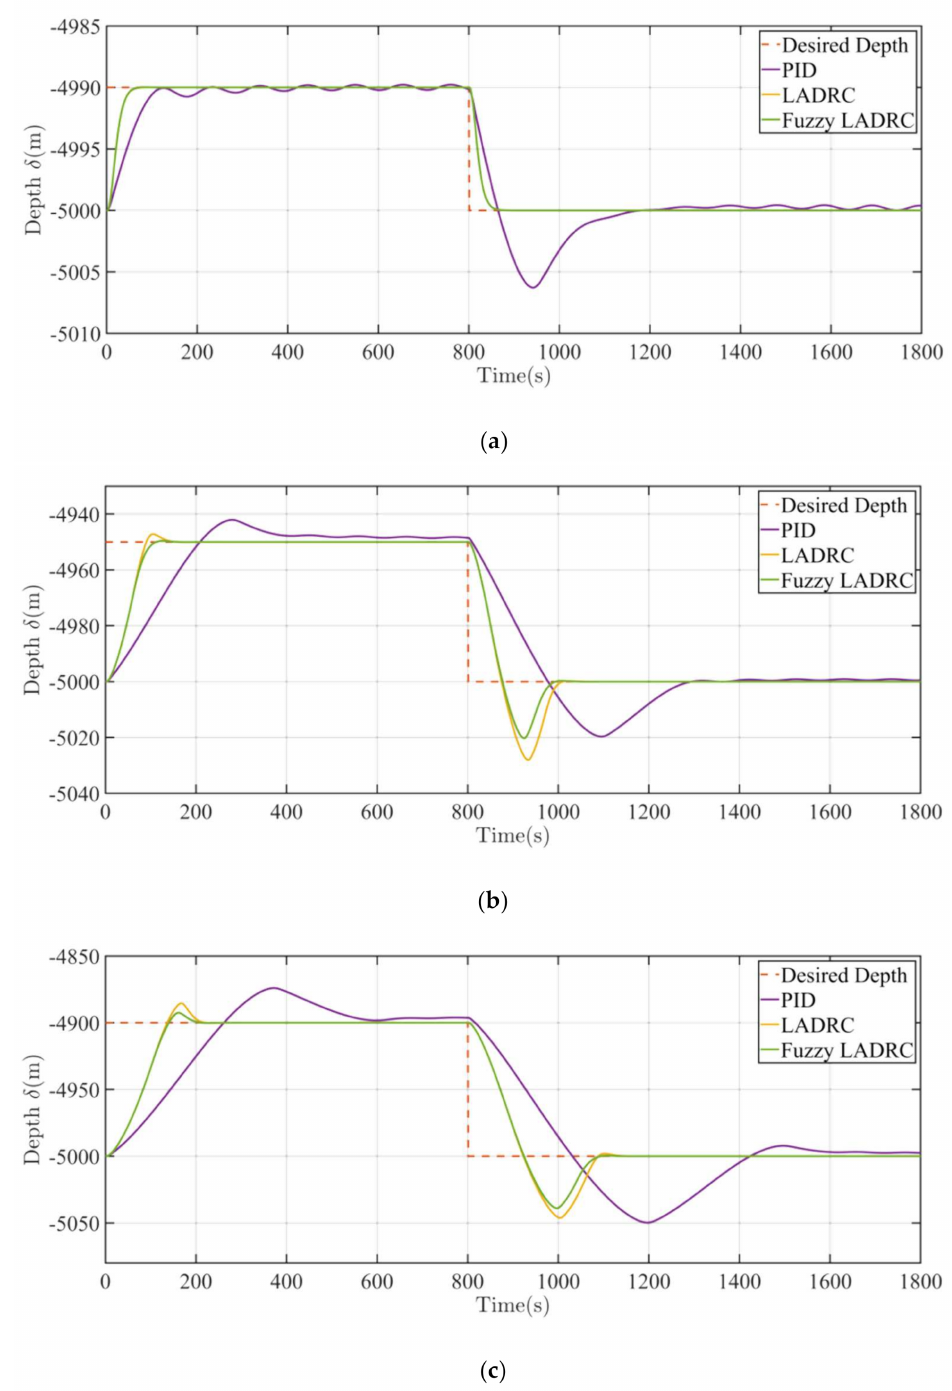
Figure 6. Control response curves of the AUV system without disturbance force using different controllers. ( a ) δ d = − 4990 m. ( b ) δ d = − 4950 m. ( c ) δ d = − 4900